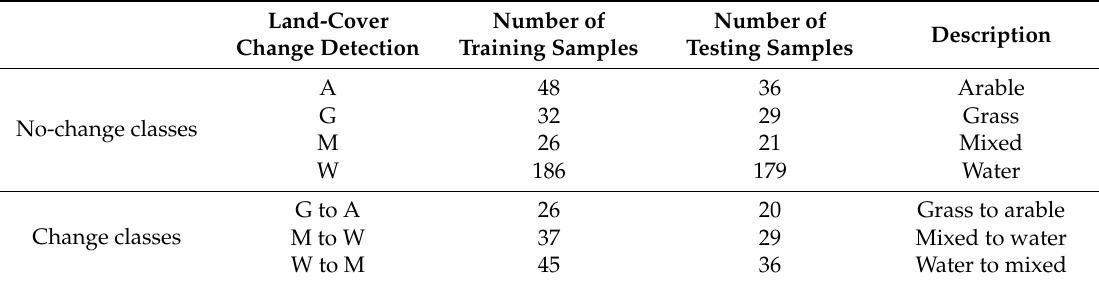
Figure 2. Locations of training (400) and testing (350) samples (∙, training samples; ×, testing samples). Table 1. Numbers of sample pixels for individual land cover change classes.